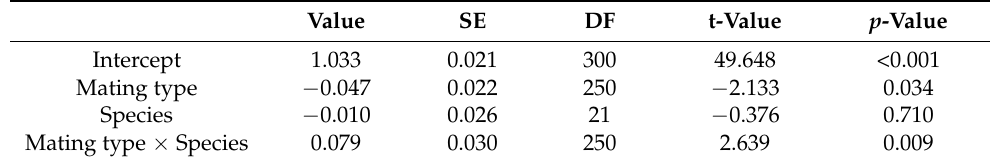
Table 2. Mating preferences regarding genetic dissimilarity in wild boar and red deer from Iberian Peninsula. Analysis conducted with data from P é rez-Gonz á lez et al. [198] and Carranza et al. [174]. Both studies conducted different approaches to assess dissimilar mating. Here, both datasets were analyzed with the same procedure (see [198]). For red deer, data from females producing daughters were selected, because dissimilar mating was only obtained for this type of female (see [174]). In order to determine the existence of dissimilar mating, we assessed the genetic relationship between parents using the standardized heterozygosity [32] of the fetuses. We considered that dissimilar mating occurred when the observed heterozygosity of fetuses was higher than expected under random mating. To simulate random mating, we randomly combined the genotypes of females (mothers) and males from the same hunting event. We randomly selected a haploid genotype of a female and a haploid genotype of a male from the same hunting event to create a diploid simulated offspring. This process was repeated 1000 times for each female and the heterozygosity of its simulated offspring was quantified. The mean heterozygosity of the 1000 simulated offspring was considered as the expected heterozygosity under random mating for this female. Therefore, each female had two variables: observed heterozygosity of its offspring (1 value for red deer, and as many values as fetuses it gestated for wild boar) and expected heterozygosity under random mating (1 value for both species). Observed and expected heterozygosity were compared using a linear mixed-effect model (LME) fitted by reduced maximum likelihood, with heterozygosity as dependent variable, mating type (observed vs. expected) and species (red deer and wild boar) and the interaction of both as fixed factors, and female within hunting event as nested random effects. Table shows the LME results for the comparison between observed and expected heterozygosity in fetuses for wild boar and red deer. Wild boar and expected heterozygosity as references. See Figure 3. SE